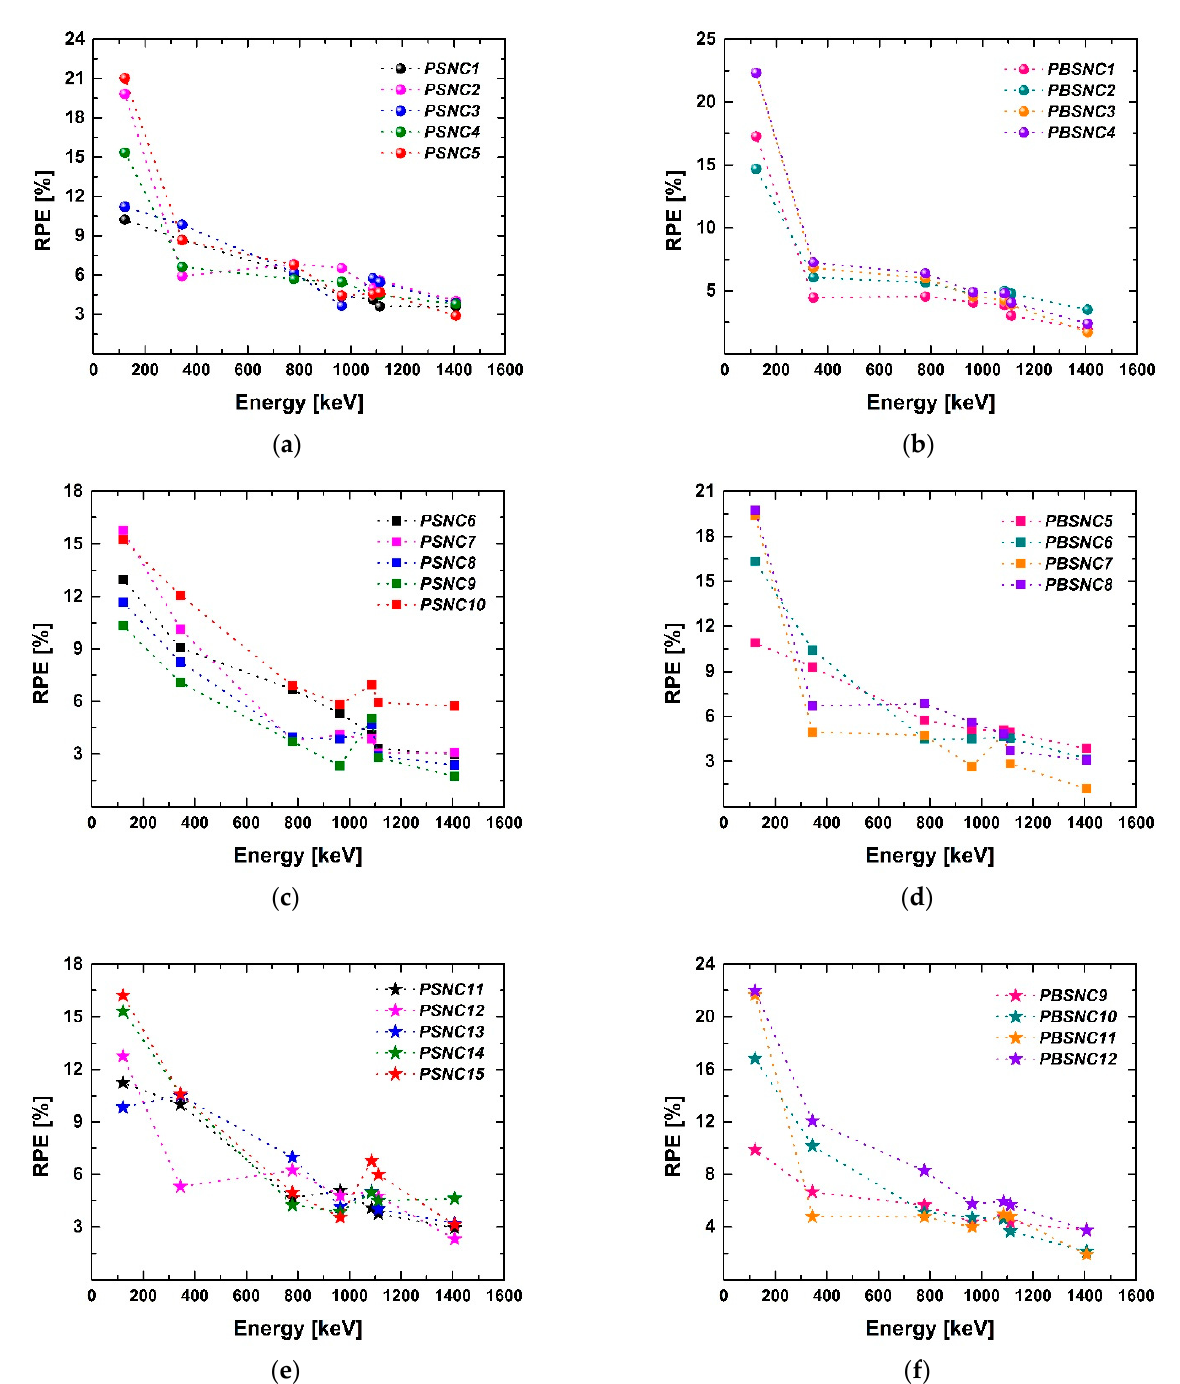
Figure 12. The RPE rates of the PS-b-PEG copolymers blended with the nanostructured SeO 2 and BN particles under a wide range of gamma irradiation energies: PSNC1, PSNC2, PSNC3, PSNC4, and PSNC5 ( a ); PBSNC1, PBSNC2, PBSNC3, and PBSNC4 ( b ); PSNC6, PSNC7, PSNC8, PSNC9, and PSNC10 ( c ); PBSNC5, PBSNC6, PBSNC7, and PBSNC8 ( d ); PSNC11, PSNC12, PSNC13, PSNC14, and PSNC15 ( e ); PBSNC9, PBSNC10, PBSNC11, and PBSNC12 ( f ). The graphs (in Figure 13) show the radiation shielding performance of the PS-PEG (1000)-SeO 2 -BN, PS-PEG (1500)-SeO 2 -BN, and PS-PEG (10,000)-SeO 2 -BN nanocomposites, respectively. In Figure 13a, it can be seen that when 50 wt% SeO 2 particles were added to the PSNC1 copolymer, the radiation shielding performance value of the PSNC2 nanocom- posite increased to 19.824. When we increased the SeO 2 ratio to 53 wt%, PSNC5 nanocom- posite was the nanocomposite with the best radiation shielding performance value of the SeO 2 -doped nanocomposites in the PS-PEG (1000) copolymer group, with a value of 21.029. When PS-PEG (1000)-SeO 2 -BN-doped nanocomposites are examined, the best ra- diation shielding performance value in this set is 22.334 in the PBSNC3 and PBSNC4 nano- composites containing PS-PEG (1000) 5 wt%-SeO 2 90 wt%-BN 5 wt% and PS-PEG (1000) 26.1 wt%-SeO 2 60.9 wt%-BN 13 wt%. When 50 wt% SeO 2 was added to the PSNC6 copolymer in the PS-PEG (1500) set containing only SeO 2 , the radiation shielding performance value in the PSNC7 nanocom- posite increased to 15.787, and the best radiation shielding performance value in the set was reached, as shown in Figure 13b. When 13 wt% BN nanoparticles were added to the nanocomposite, the best radiation shielding performance value was obtained with PBSNC8, which consists of PS-PEG (1500) 26.1 wt%-SeO 2 60.9 wt%-BN 13 wt%. The radi- ation shielding performance values for PS-PEG (10,000) are presented in Figure 13c. The radiation shielding performance value of the PSNC11 polymer increased from 11.240 to